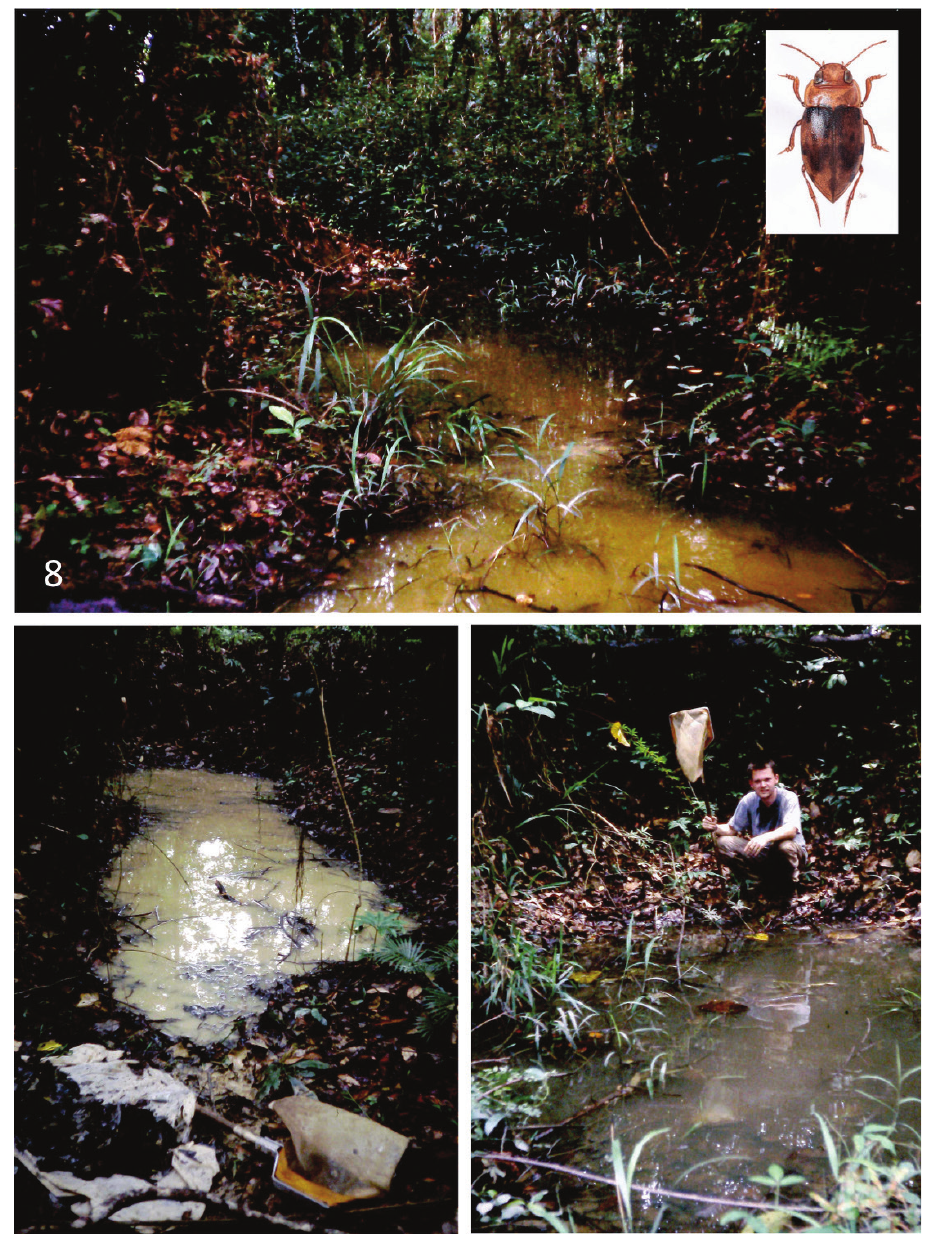
Figure 8. Habitat of Leiodytes kualalipis sp. n. near Kuala Lipis, West Malaysia. Drawing of beetle by D. Paramonov